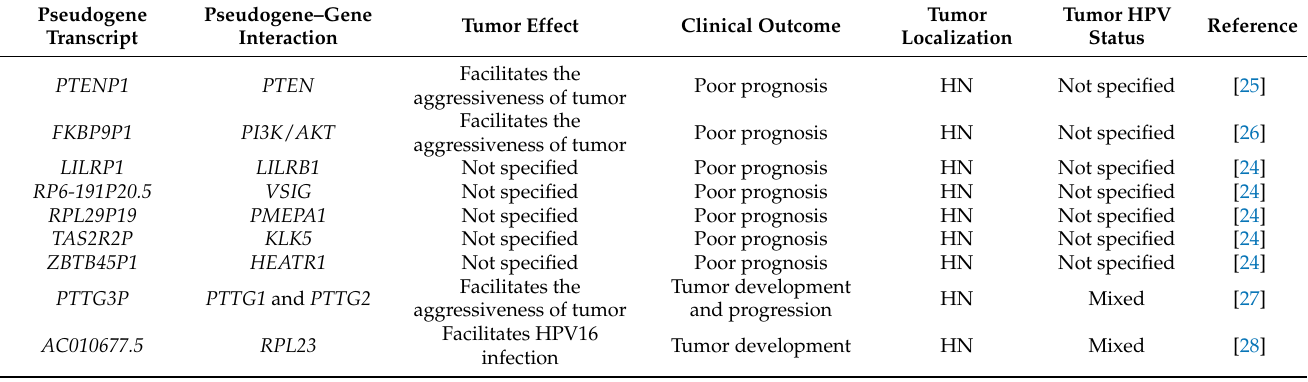
Table 1. Pseudogene transcript, pseudogene–gene interaction, tumor effect, clinical outcome, tumor localization, and human papillomavirus status in head and neck cancer described in the literature. Pseudogene